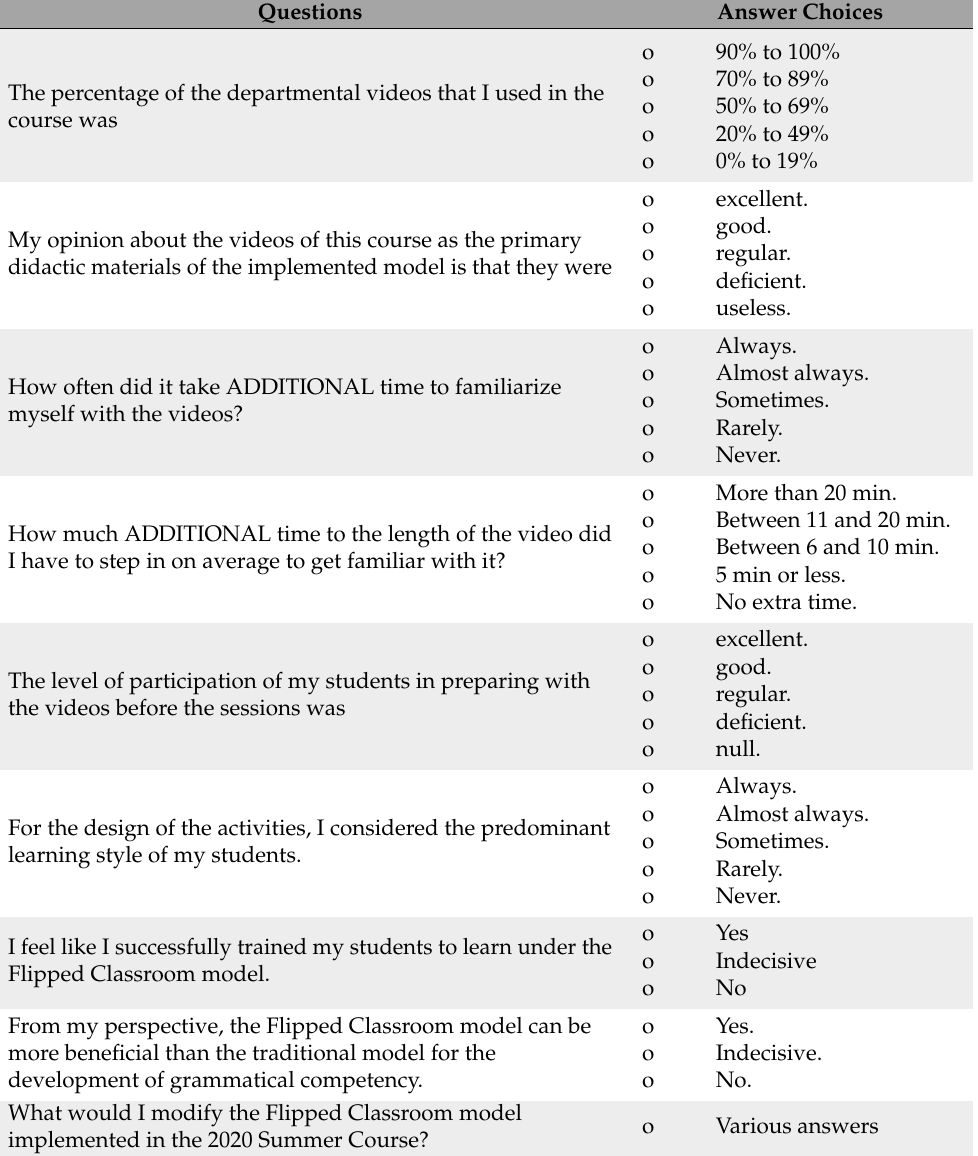
Table 7. Questions from the opinion survey for teachers about the course taught in the virtual Flipped Classroom model, supported by videos from the YouTube social